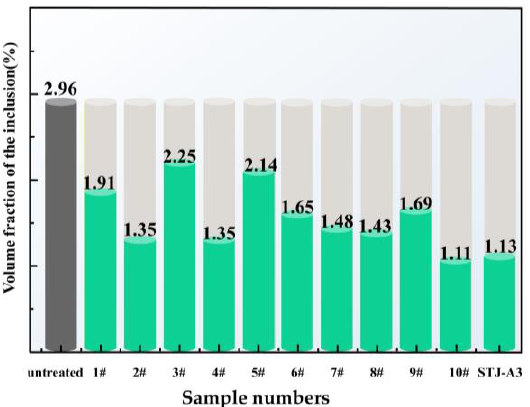
Figure 10. The pores and inclusions contents of untreated, fluxes #1 – #10 and STJ-A3 refined samples.